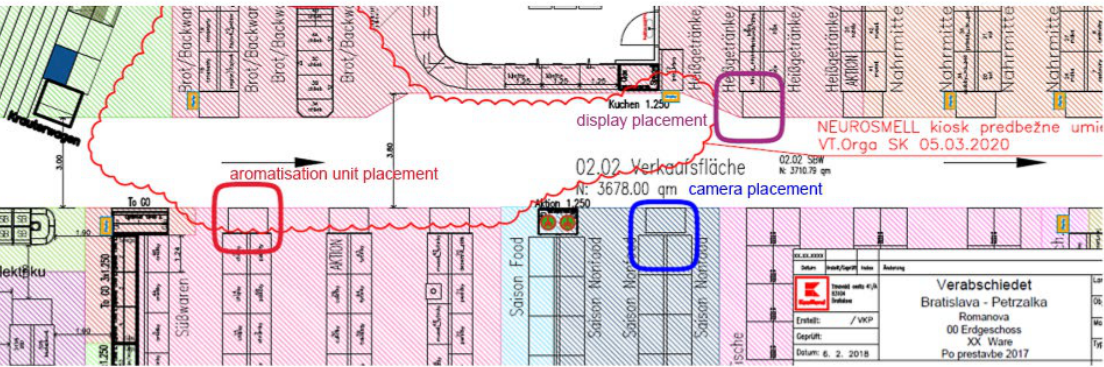
Figure 2. Location of aromatising units in a retail company.